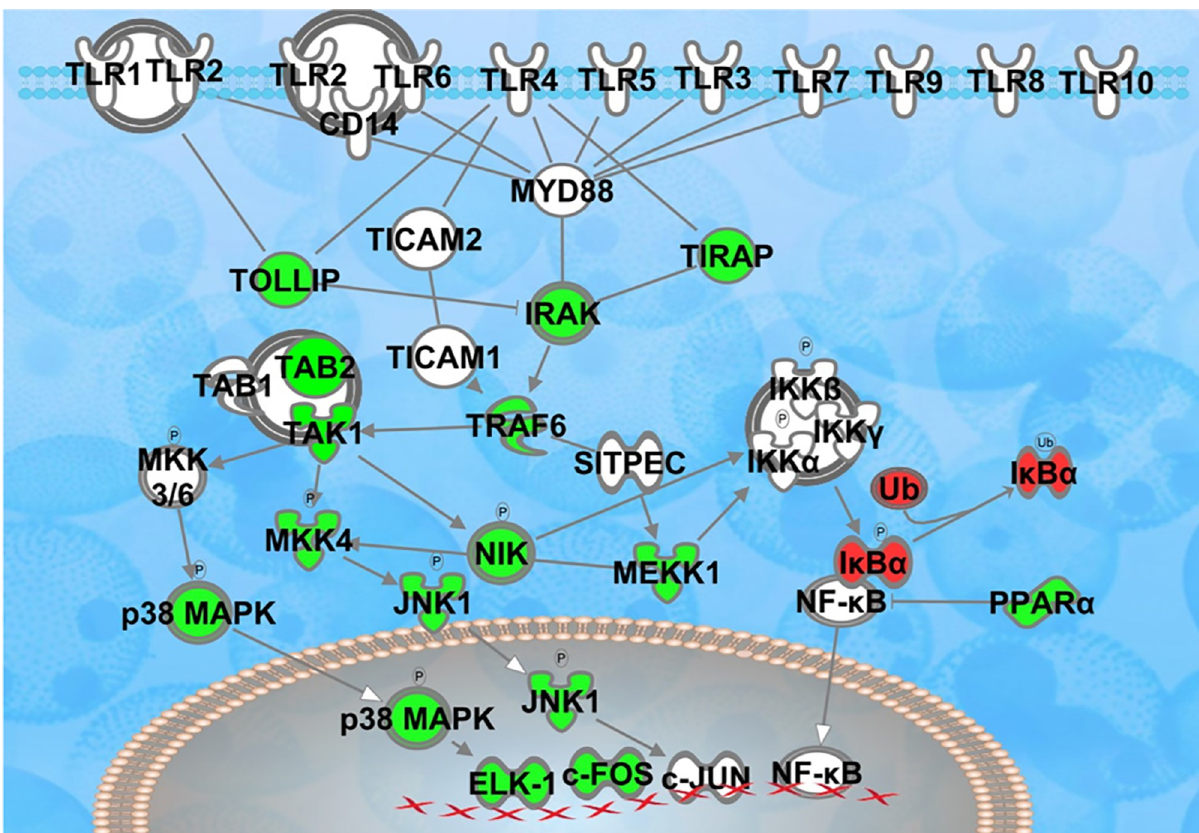
Fig 8. Regulation of TLR-related transcripts in the nucleus accumbens of enriched vs. isolated rats. The figure shows transcripts significantly downregulated (green symbols) or upregulated (red) in the Toll-like Receptor Signaling pathway, as described by Ingenuity Pathways Analysis software. The pathway as a whole was significantly regulated (-log (p) =